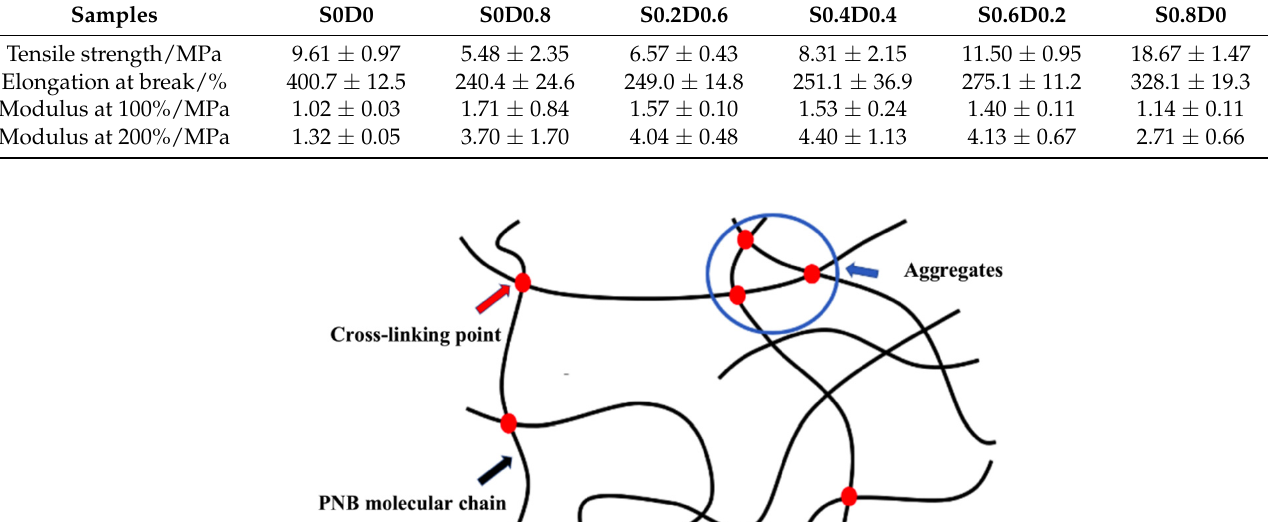
Figure 4. Schematic diagram of the structural characteristics with DCP crosslinking network. Table 3. Mechanical properties of PNB at 24 °C.